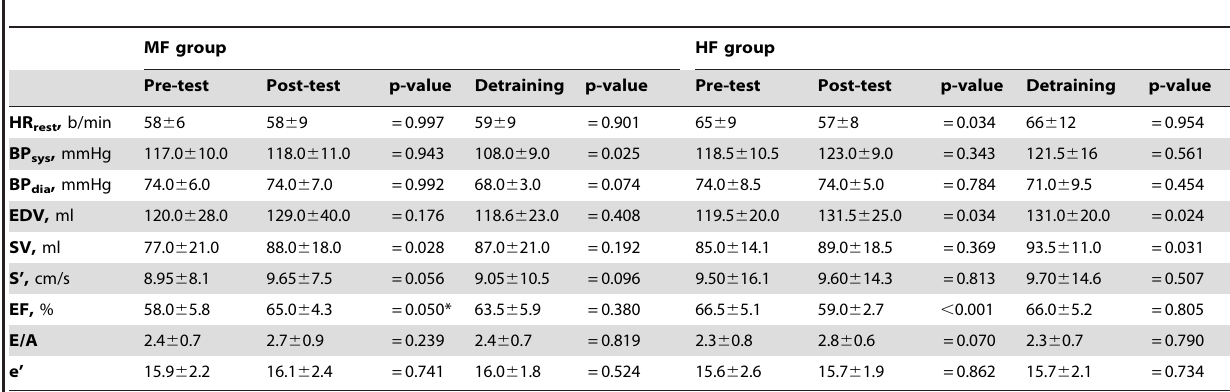
Table 3. Parameters of heart function for both groups before and after training and after detraining.